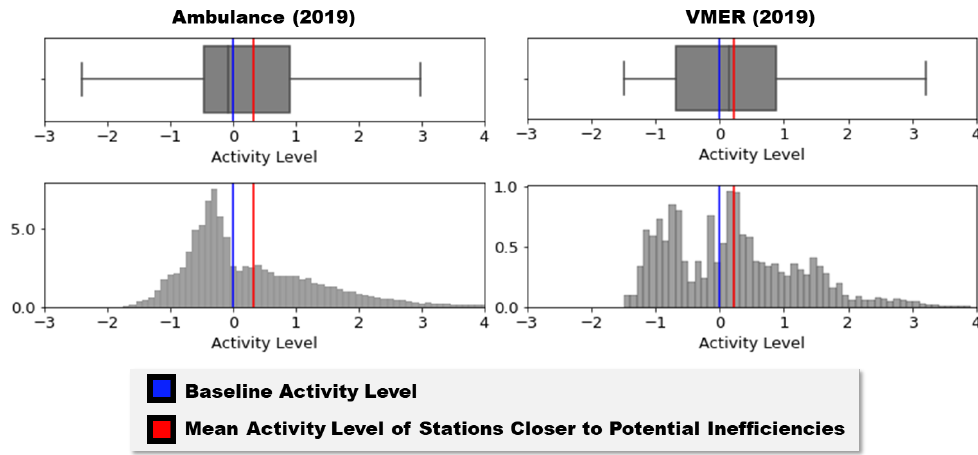
Figure 7. Distribution of the activity level of closer stations in the context of potential inefficiencies for the year 2019. Histogram counts are in thousands.